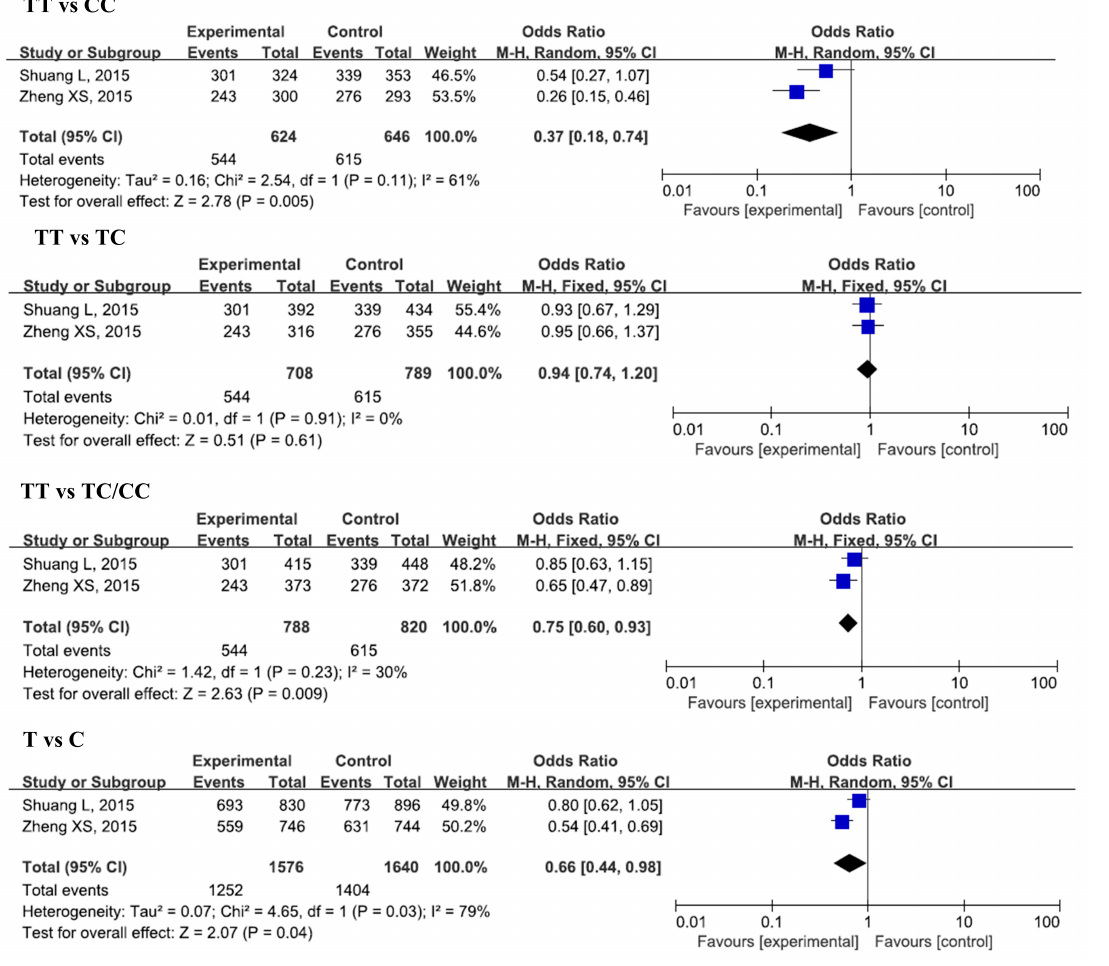
Figure 3. Forest plots of odds ratios for the association of IL-17A rs3748067 with risk of CAD.